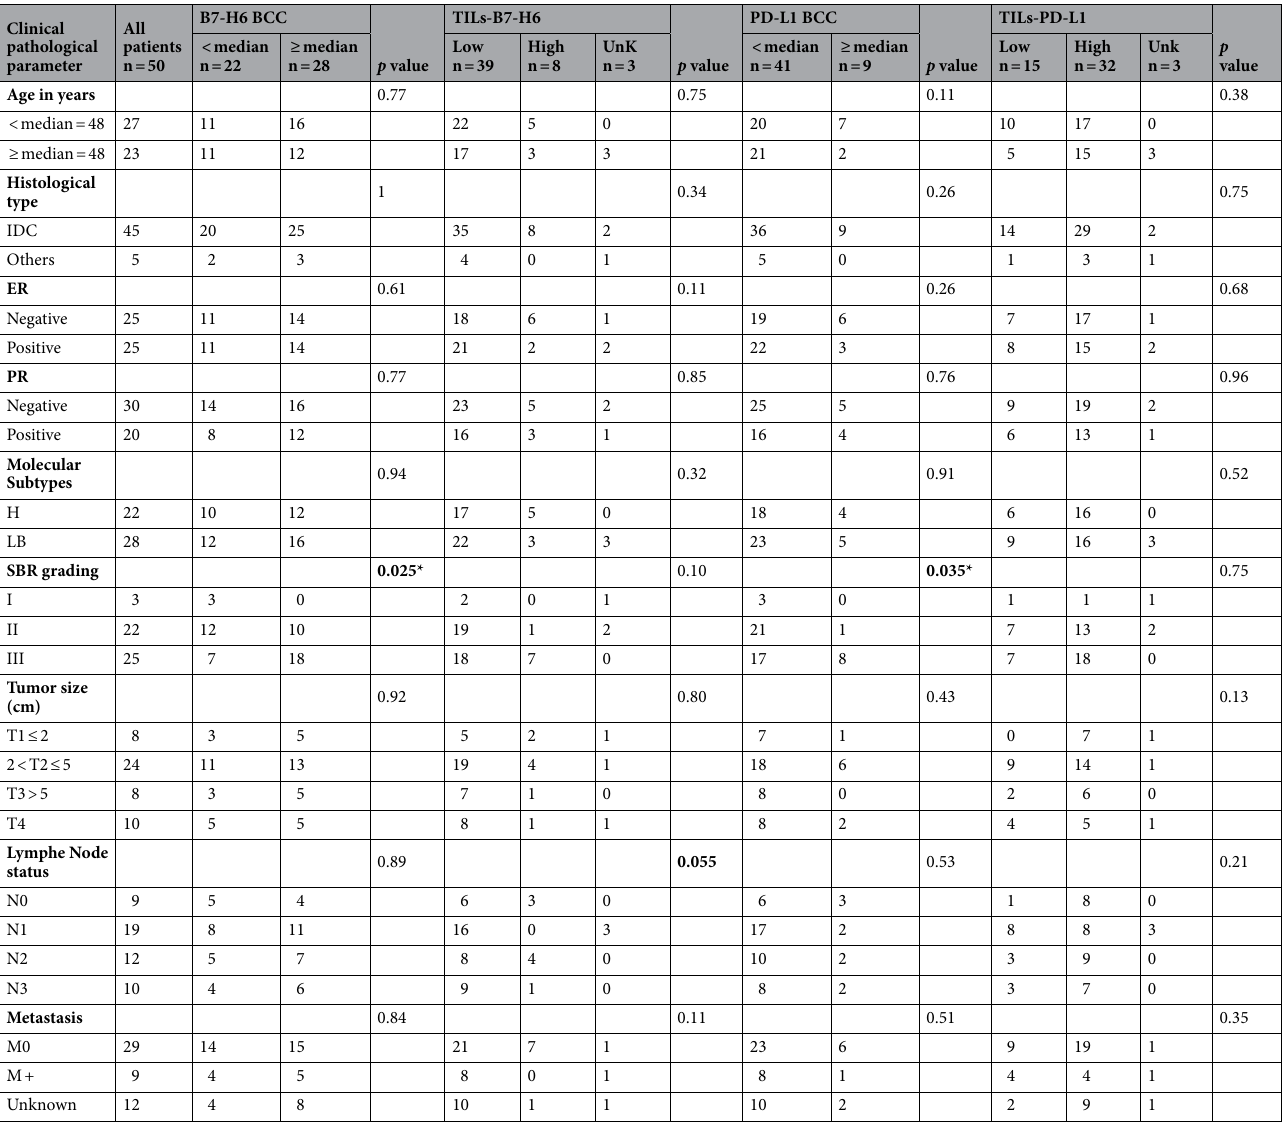
Table 2. Associations of B7-H6 and PD-L1 expression with clinical parameters in Her2 positive primary breast cancer patients. Variable between groups presented in frequency tables evaluated by Chi-Square test. Two sided p values are considered statistically significant if < 0.05 and are indicated in